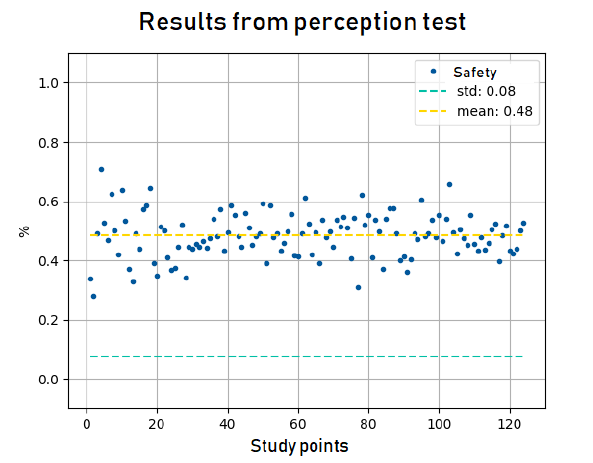
Figure 6. Architectural beauty perceived from the points of study.